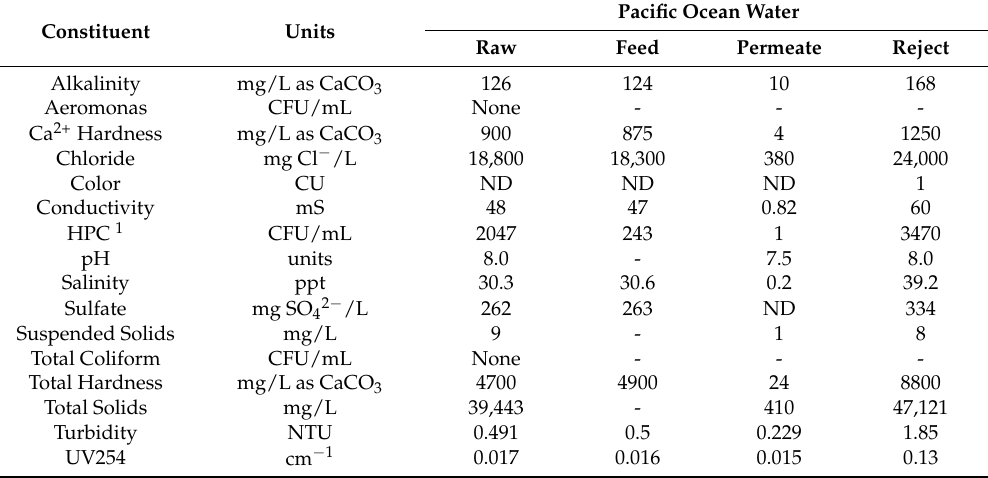
Table 5. Pacific Ocean Water Analytical Results 1